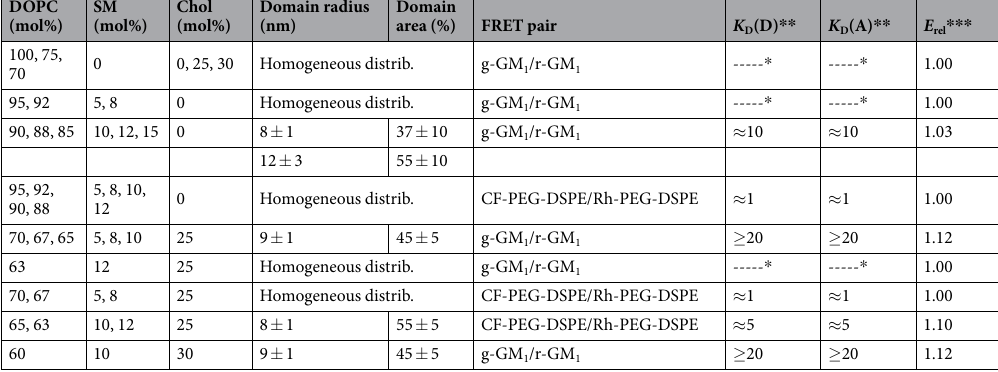
Table 1. The average radius and fractional bilayer area of the nanodomains, distribution constants K D and relative FRET efficiencies E rel (for definition see Materials and Method section) for two different donor-acceptor pairs in DOPC/SM and DOPC/Chol/SM mixtures. All lipid mixtures that are given in the same row provided overlapping fluorescence decays. For this reason, the same values are determined for these parameters in the mentioned bilayers. The output parameters were determined by MC-FRET. The total amount of D/A molecules was 1 mol% at max. * no nanodomains detected at the given bilayer compositions; ** as determined by MC- FRET; *** the estimated error in Erel was below 1%.